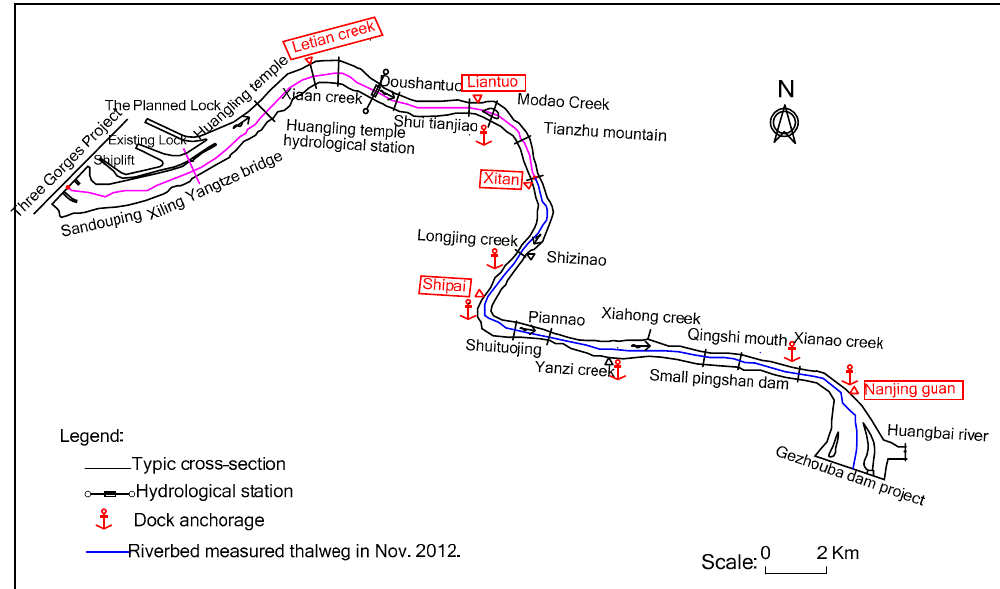
Figure 2. Schematic of river channel between the Three Gorges Dam (TGD) and the Gezhouba Dam (GZD).